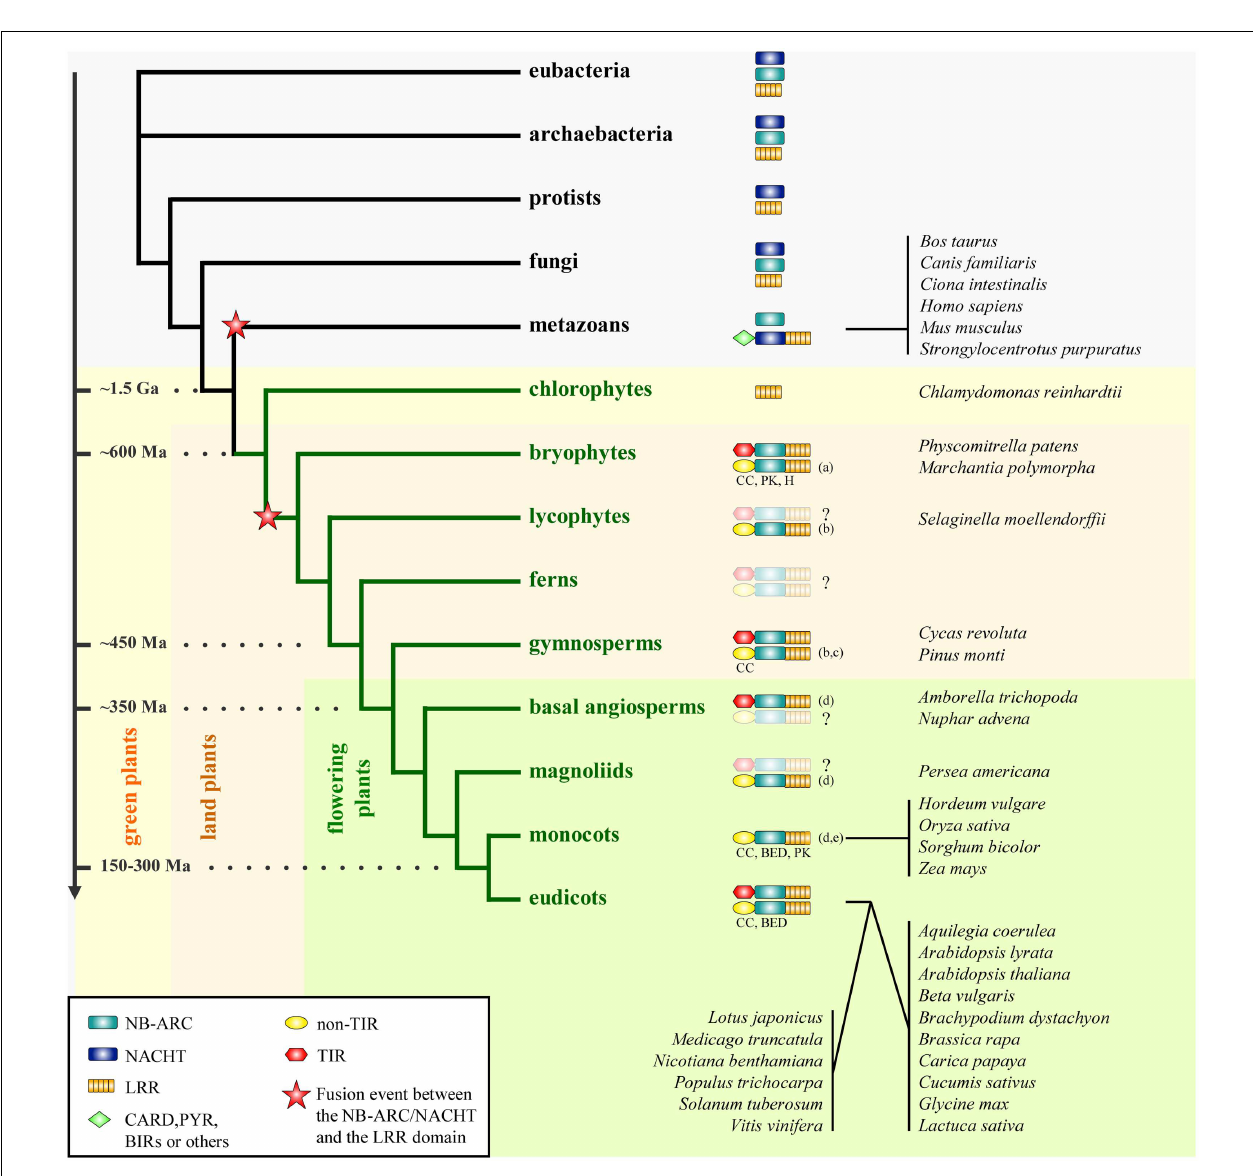
FIGURE 1 | Phylogenetic distribution of the NLR family .The distribution of the individual domains constitutive of NLRs (NB-ARC, NACHT, and LRR) and the different groups of NLRs are mapped on a simplified phylogenetic tree.The fusion events between either the NB-ARC or the NACHT domain and the LRR domain presumably occurred as indicated on the phylogenetic tree.The structural properties of the N-termini of plant NLRs in the non-TIR group are indicated if the information is available (CC, coiled-coil; BED, BED-DNA-binding zinc finger; H, α / β -hydrolase; PK, protein kinase; for